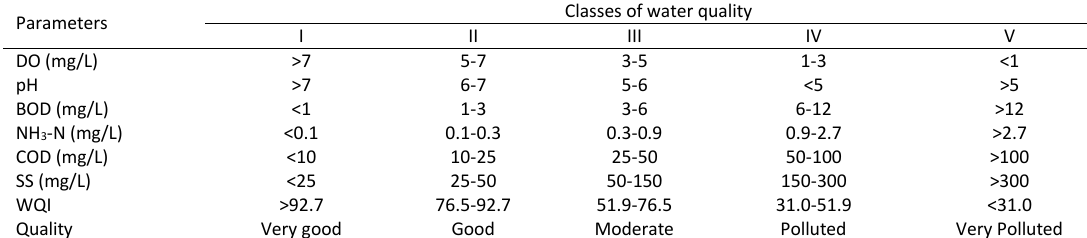
Table 2: DOE classification of the local water quality based on index range/ WQI class (DOE,